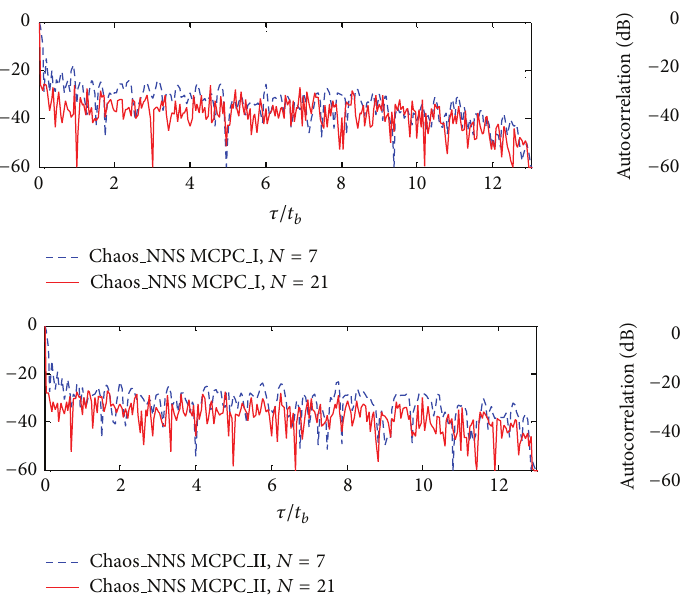
Figure 10: Influence of period number on autocorrelation.